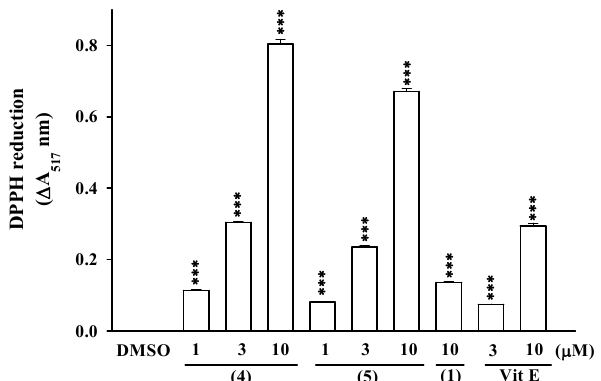
Figure 6. DPPH radical scavenging effects of compounds 1 , 4 and 5 isolated from the n -butanol